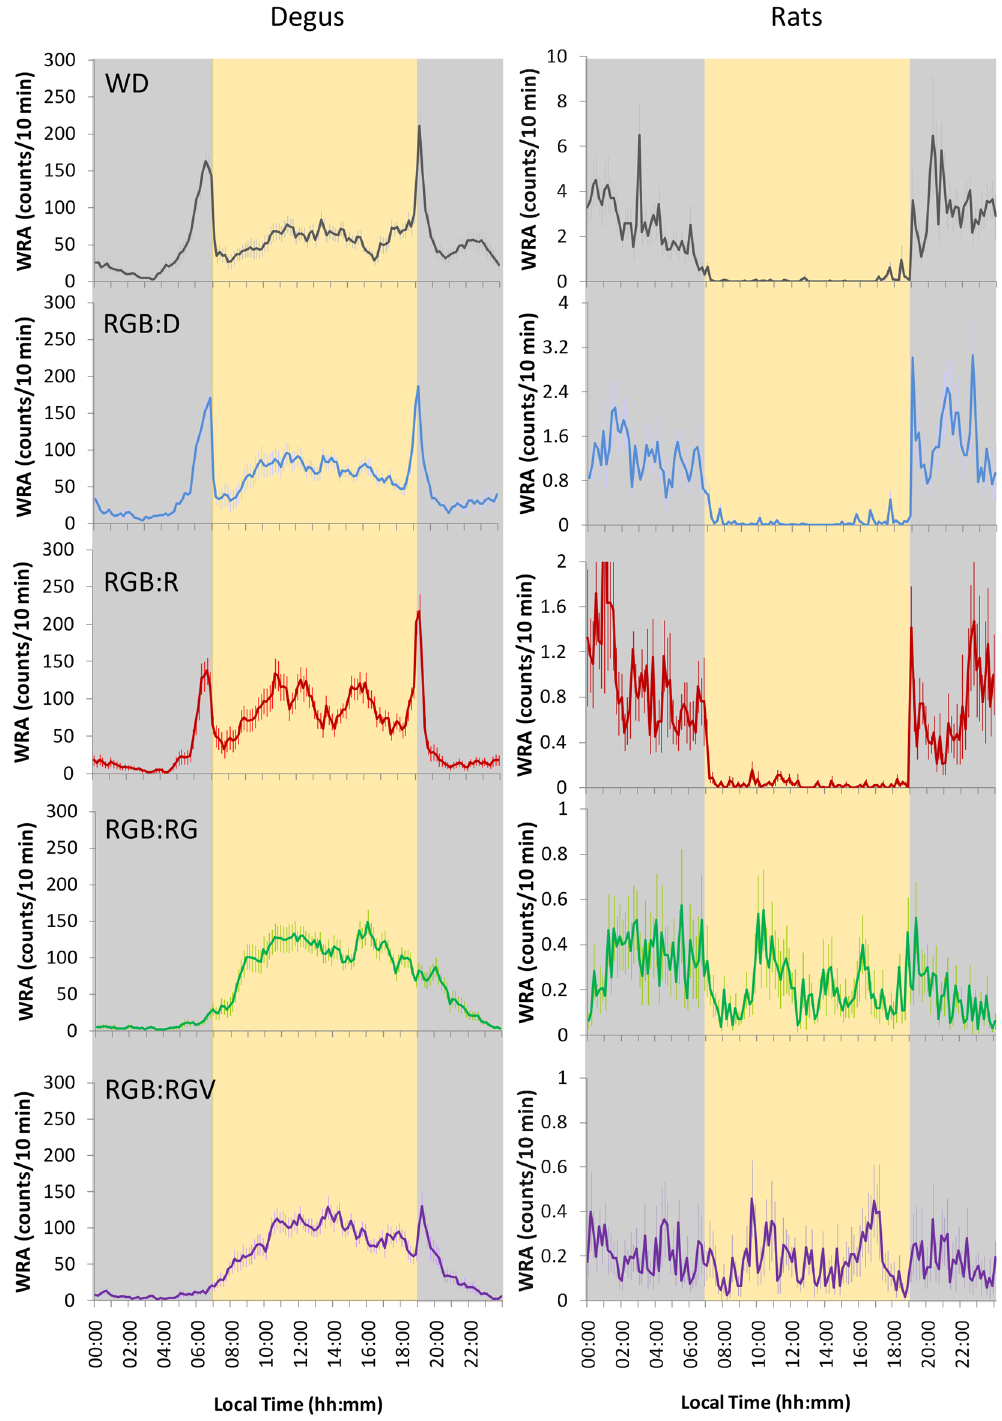
Figure 3. WRA mean waveforms. Mean waveforms of wheel running activity for degus (left panel, n = 27) and rats (right panel, n = 12) under the different lighting cycles: W:D (grey line), RGB:D (blue line), RGB:R (red line), RGB:RG (green line) and RGB:RGV (purple line) (for more details, see the Materials and Methods section). Pale lines represent the SEM. Grey and yellow columns indicate nocturnal and diurnal periods, respectively. For details on lighting conditions, see the Fig. 9 legend. Please note that the WRA scale for rats is not the same as for degus, or for the different light